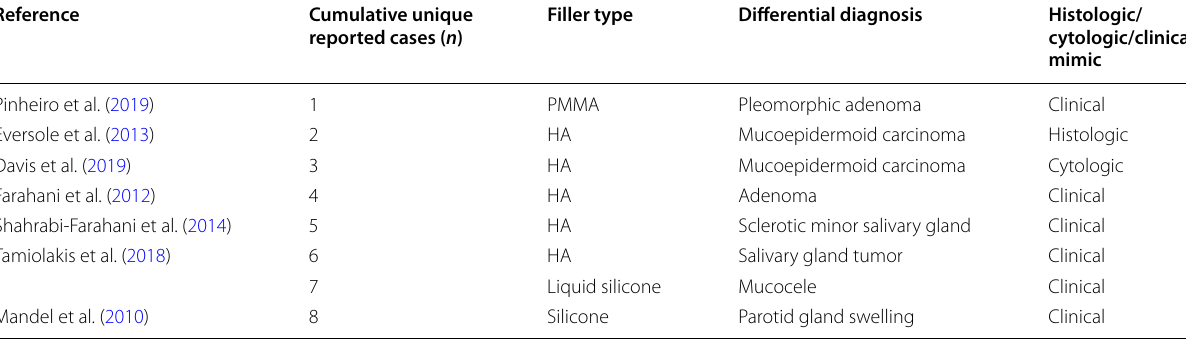
Table 1 Reported adverse granulomatous reactions to dermal fillers mimicking salivary gland